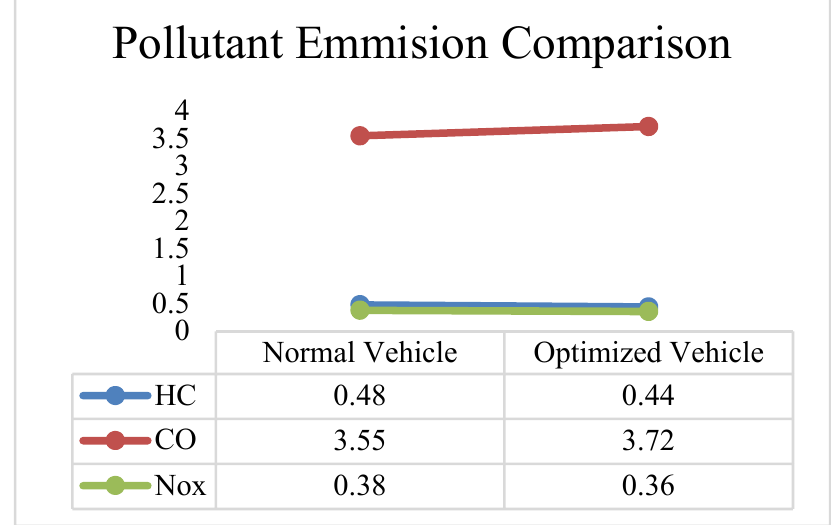
Figure 9. Pollutant emission comparison. Figures 10 and 11 represent the power consumed by each component of an HEV. An analysis of Figures 10 and 11 indicates that the power consumed by the ICE is substantially reduced after the optimization process. The impact of optimization is a better fuel efficiency obtained during vehicle